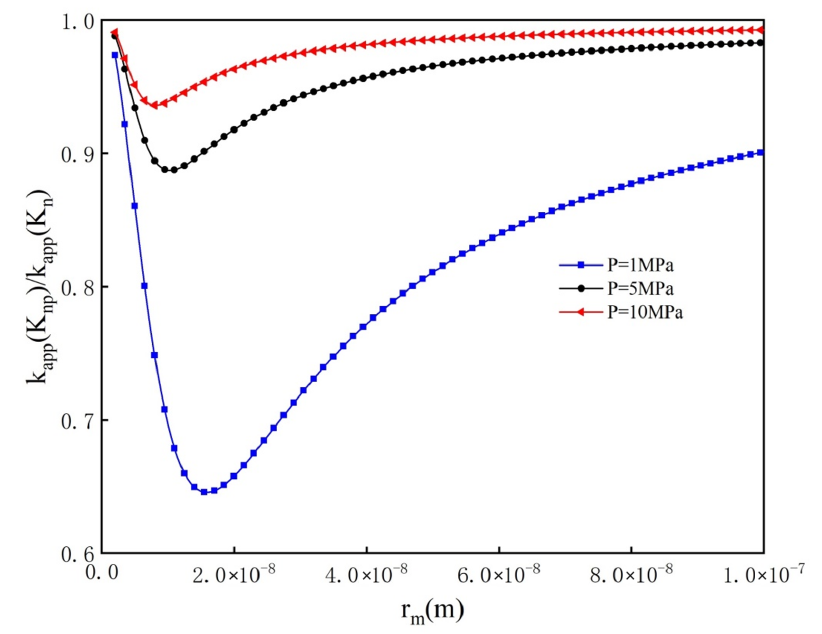
Figure 4. Apparent permeability ratio vs. pore radius with K n